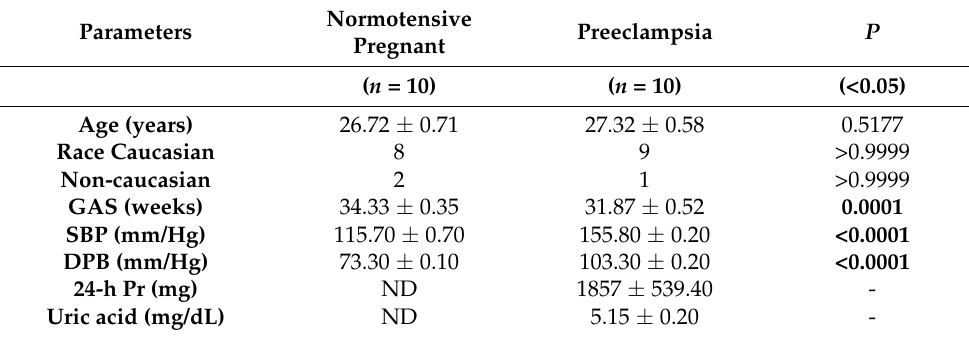
Table 1. Clinical, demographic, and biochemical characteristics of study subjects.